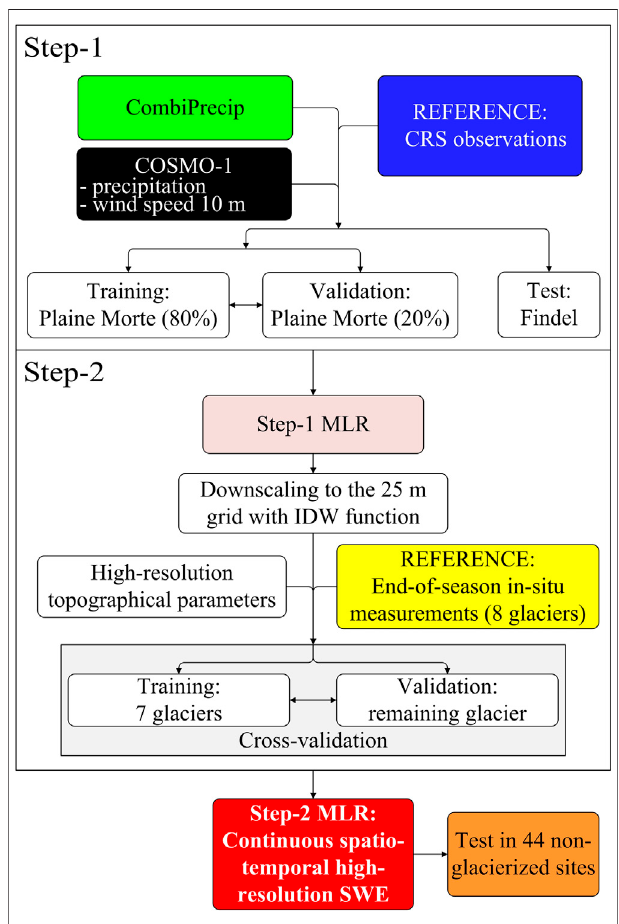
FIGURE 2 | Flowchart showing the main assimilation, processing modelingandvalidationsteps.Thecoloroftheboxesmatchesthecolorofthe lines in the different plots in the